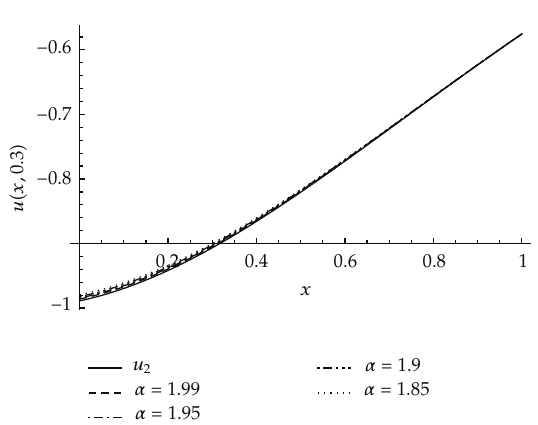
Figure 4: u (cid:2) x, 0 . 3 (cid:3) of Example 4.2 Case 1 for 4th-order HPM approximation as parameterized by α